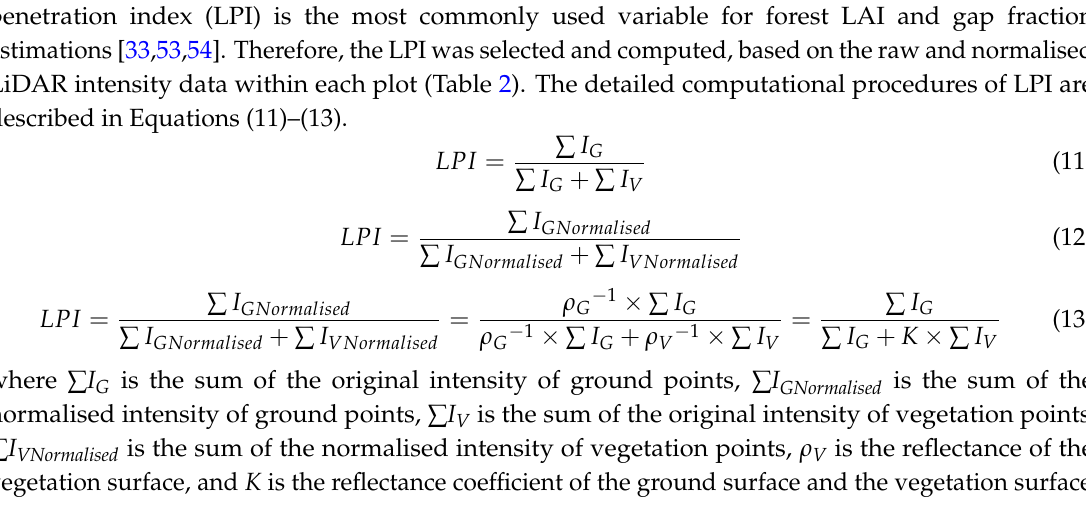
Table 2. Description of the LiDAR intensity